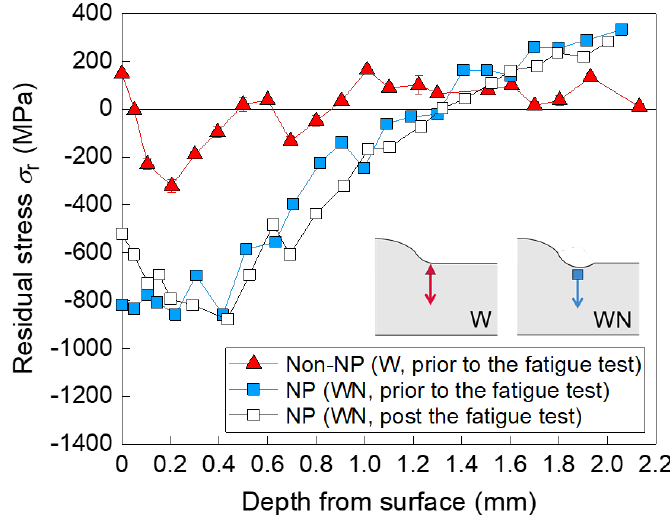
Figure 8. Residual stress distribution at the weld toe. The longitudinal residual stress measurement of the weld toe for W and WN was obtained prior to the fatigue test. The residual stress for WN after the fatigue test at a fatigue limit of σ w = 240 MPa was also measured.